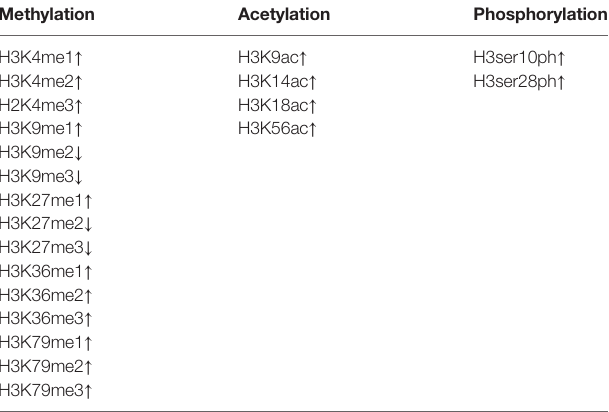
TABLE 2 | Histone H3 modi fi cations.